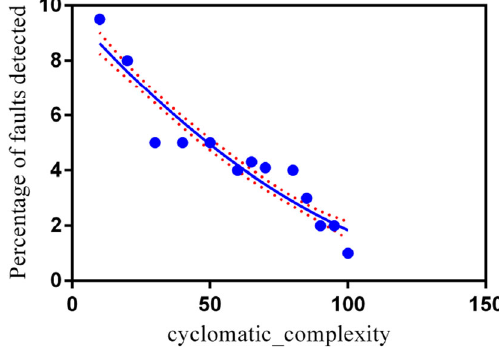
Fig. 11 Complexity-fault analysis of LBS (Spearman r s = − 0 . 96)